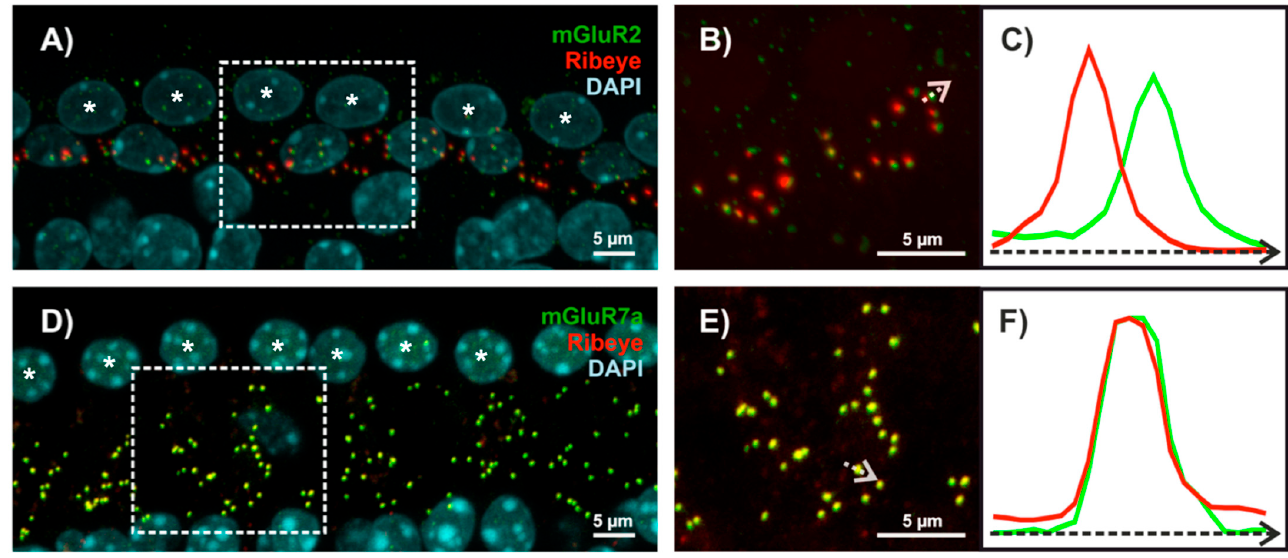
Figure 2. Localization of metabotropic glutamate receptors at ribbon synapses of inner hair cells. ( A , D ) Confocal z-projections of cochlear wholemounts of adult mice that were triple-labelled with specific antibodies for mGluR2 or mGluR7a (green), the pre-synaptic marker protein ribeye (red), and DAPI to visualize cellular nuclei (cyan). Fluorescent signals for mGluR2 are in close vicinity to pre-synaptic ribbons ( A ), while mGluR7a signals completely overlap with ribeye, resulting in yellow colour ( D ). Cellular nuclei of inner hair cells are labeled with asterisks. Panels ( B , E ) show enlarged views of fluorescent signals present in the two boxes indicated by white dashed lines in ( A , D ). Fluorescent signal intensities were measured along the white arrows and fluorescent profiles are compared in ( C , F ).